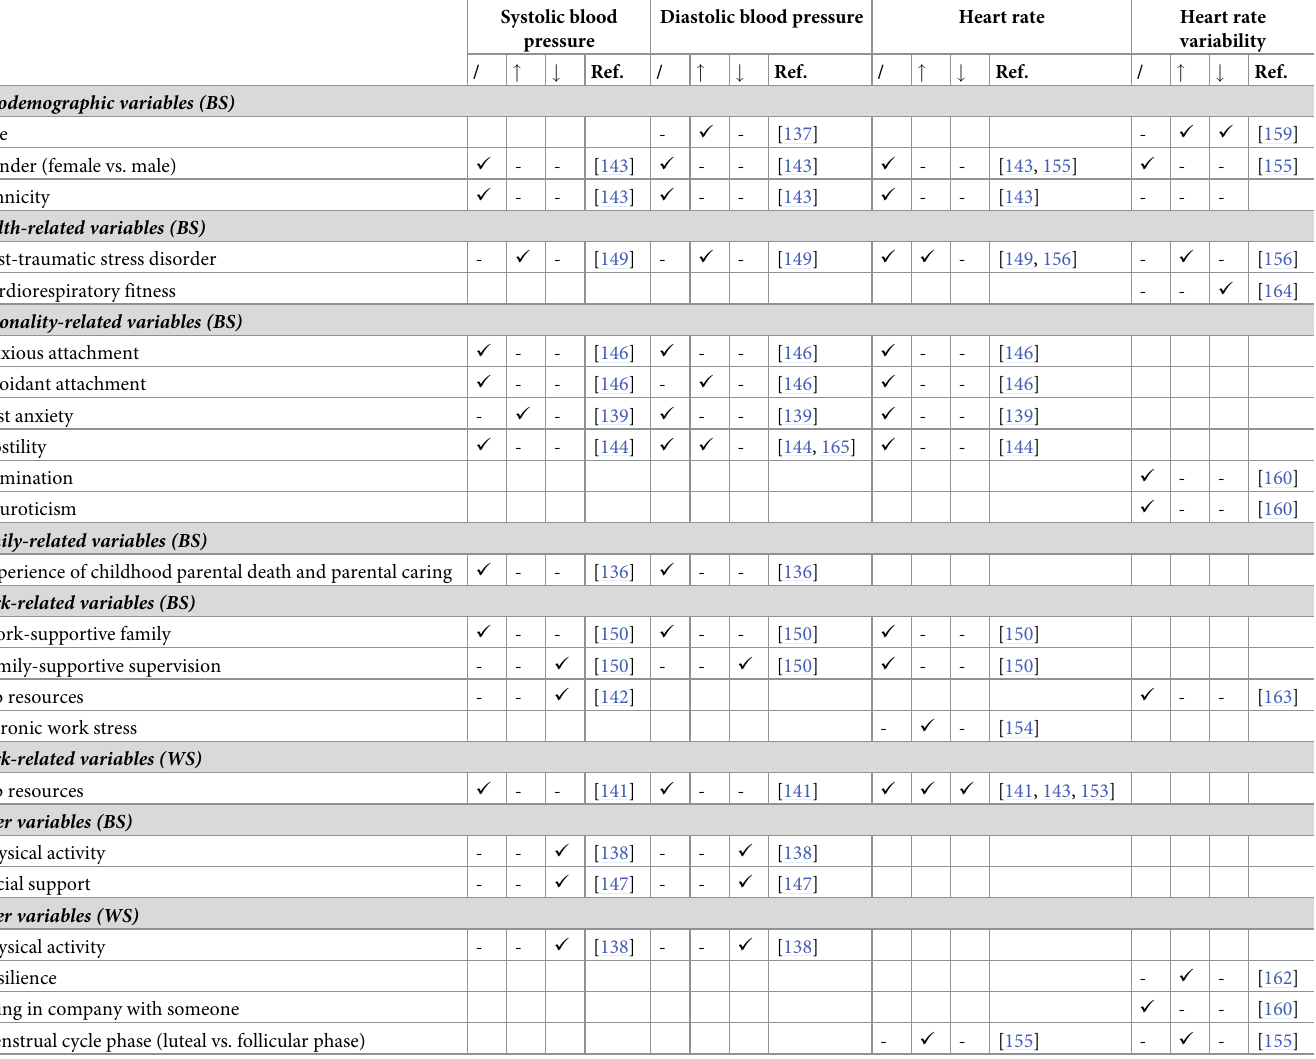
Table 4. Moderating variables on within-subject associations between acute stress and cardiovascular